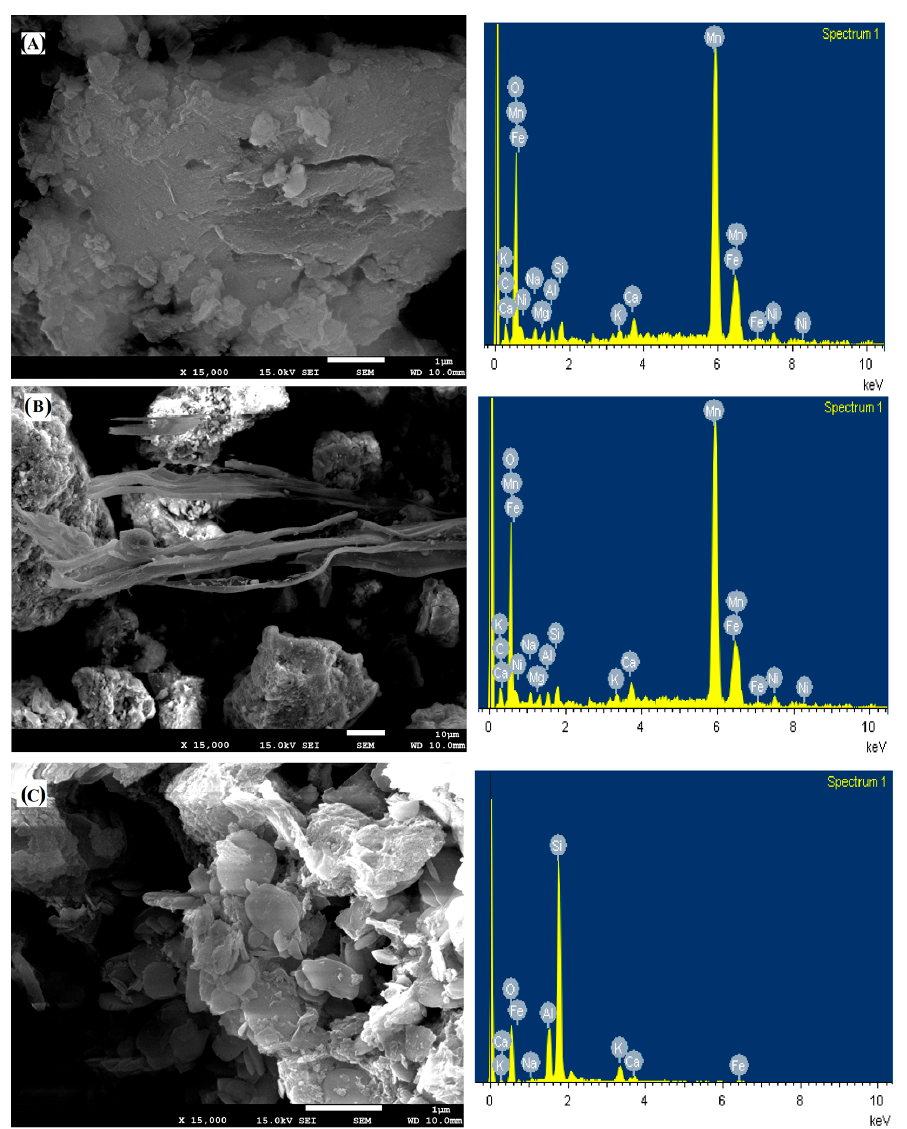
Figure 12. Scanning electron microscopy images with energy dispersive spectrometry (SEM-EDS) of ocean manganese nodules ( A ), reduced ore ( B ), and acid leaching residue ( C ).